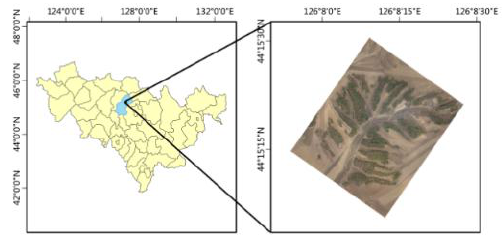
Figure 2. Study area in Jiutai, Jilin Province, China Parameters of UAV system